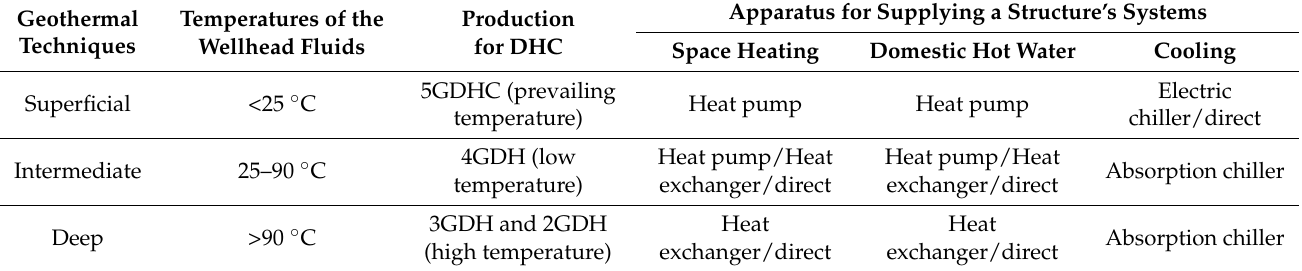
Table 1. Geothermal Energy Classifications